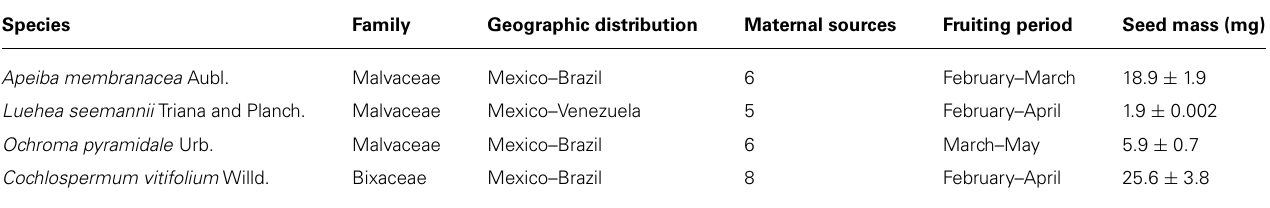
Table 1 | Characteristics of focal species, including family, geographic distribution, number of maternal sources used in the burial experiment, fruiting period, and mass of fresh seeds at Barro Colorado Island, Panama. Species Family Geographic distribution Maternal sources Fruiting period Seed mass (mg) Apeiba membranacea